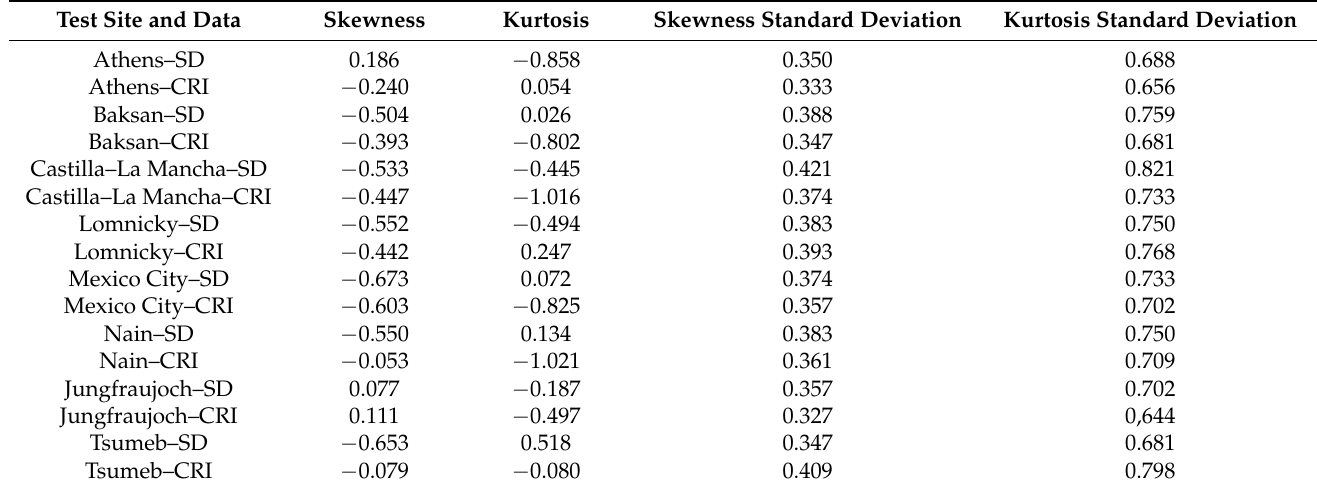
Table 4. Skewness and kurtosis values (SD, speckle amount; CRI, cosmic ray intensity).